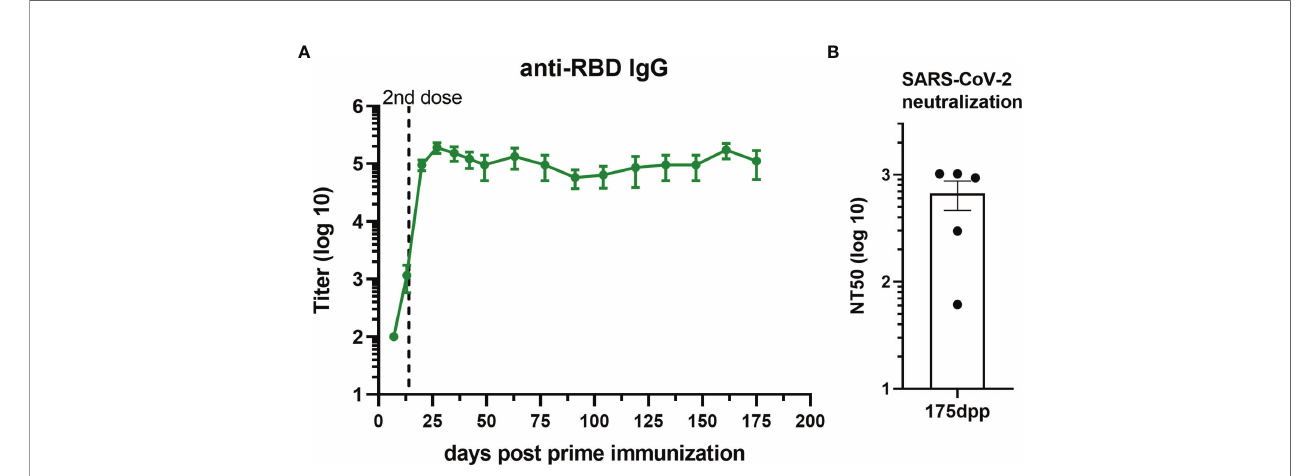
FIGURE 4 | RBD+Alum+U-Omp19 immunization induces a long-term antibody response. (A) Kinetics of RBD-speci fi c IgG endpoint titers in sera of RBD+Alum+ U-Omp19 BALB/c immunized animals (n = 5) by ELISA. Points are means ± SEM. (B) Bar plot of neutralizing-antibody titer against ancestral SARS-CoV-2 at day 175 post prime immunization (dpp). Neutralization titer was de fi ned as the serum dilution that reduces 50% the cytopathic effect (NT50). Bar is the mean ± SEM.